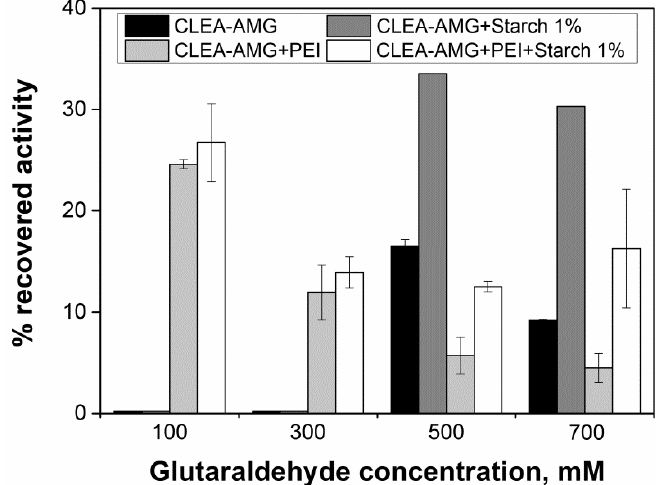
Figure 5. CLEAs of amyloglucosidase (AMG 300L) prepared using only enzyme, co-aggregation with polyethyleneimine (protein/PEI mass ratio of 1:1) and/or starch (1%, w / v ). Assay conditions: ethanol as precipitant (volume ratio of 1:9, enzyme solution pH 7.0 or 10.0/ethanol), 30 min precipitation in an ice bath, glutaraldehyde as a cross-linker (100–700 mM), 16 h crosslinking under gently stirring at 4 °C. Note: Values are shown as the mean of duplicate experiments ± s.d.